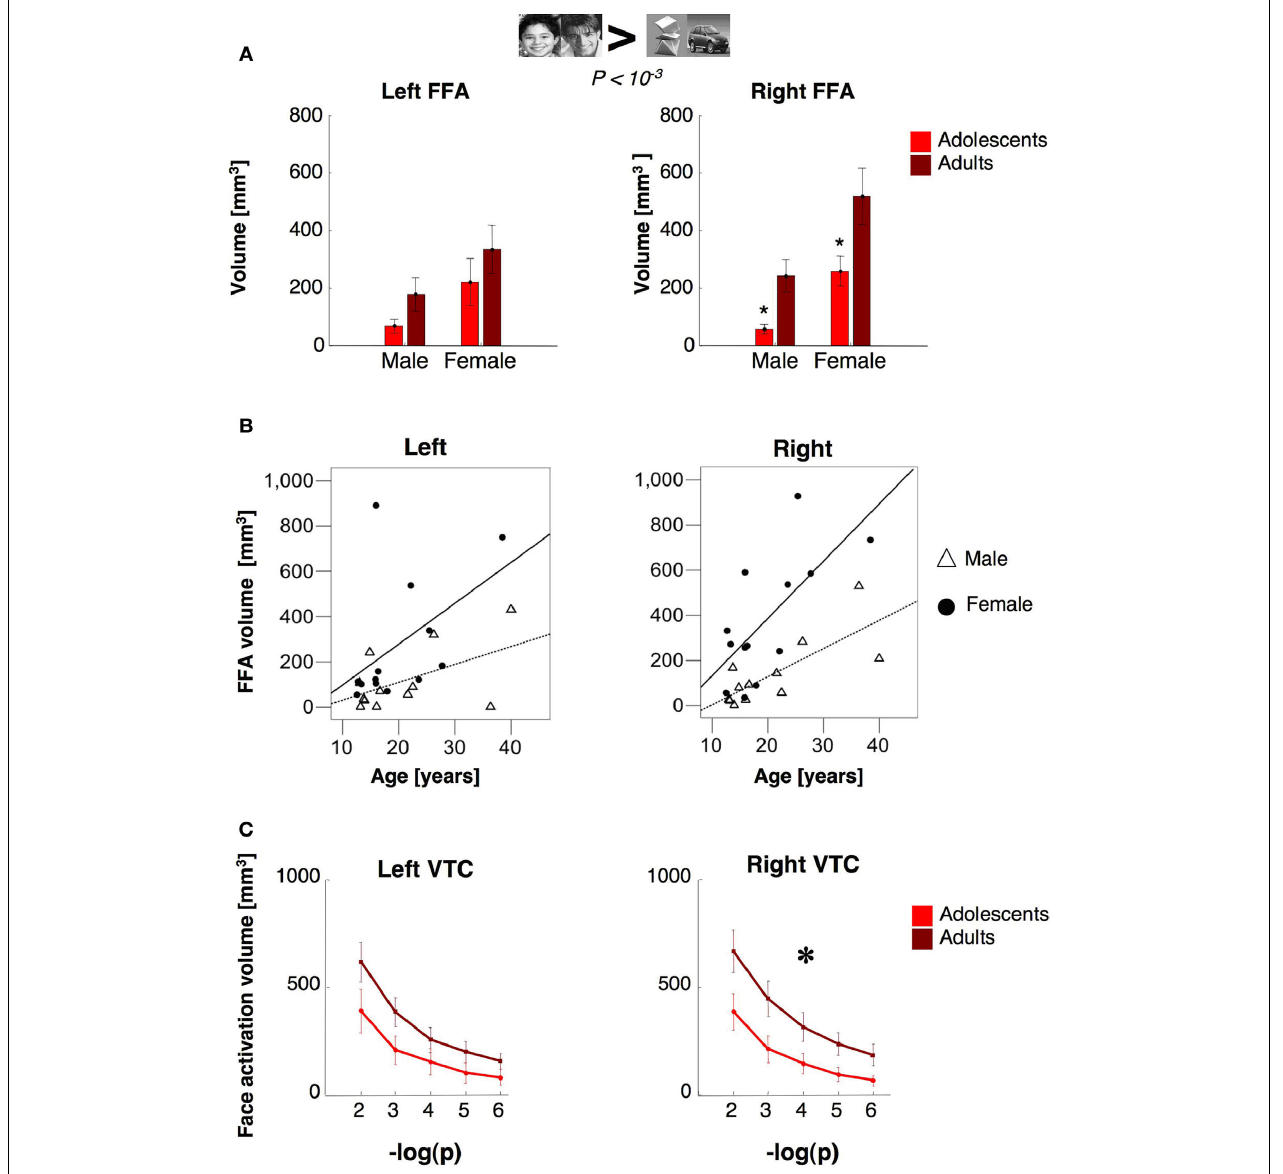
P = 0.004; lFFA vs. age in females: r = 0.48, P = 0.09; in males: r = 0.52, P = 0.08). Open triangles : males, n = 12; Filled circles : females n = 13. (C) The